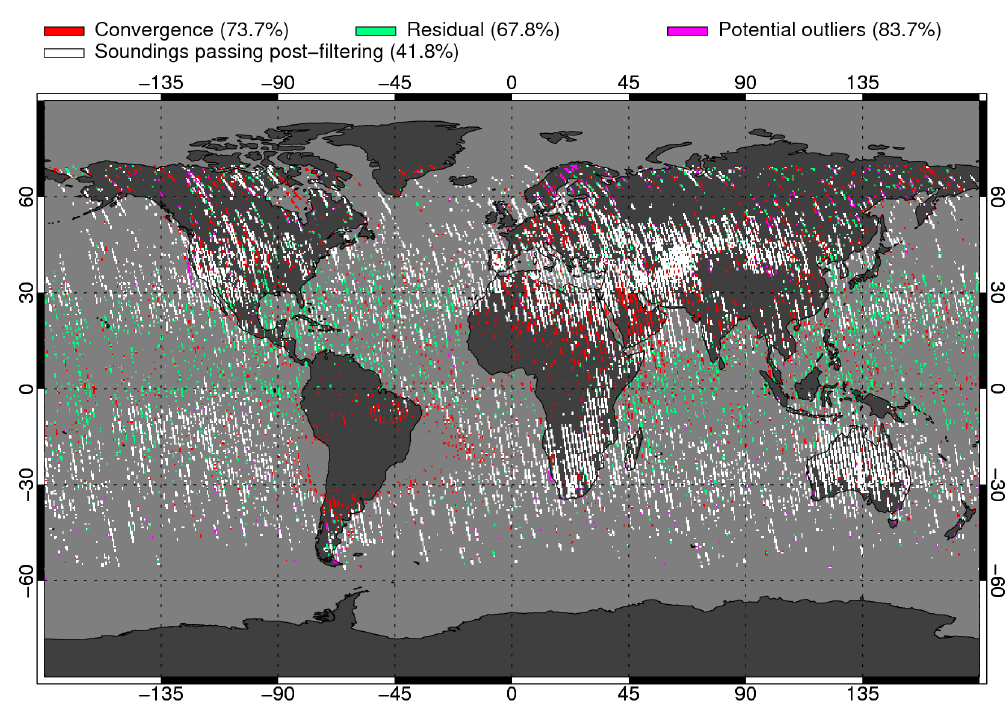
Figure 7. Post-filtering statistics for April and August 2015. The filters are applied in the order: convergence, residual, and potential outliers (see main text for a description). The colors represent filter activity and soundings passing all filters are shown in white. Numbers in brackets represent filter throughputs.